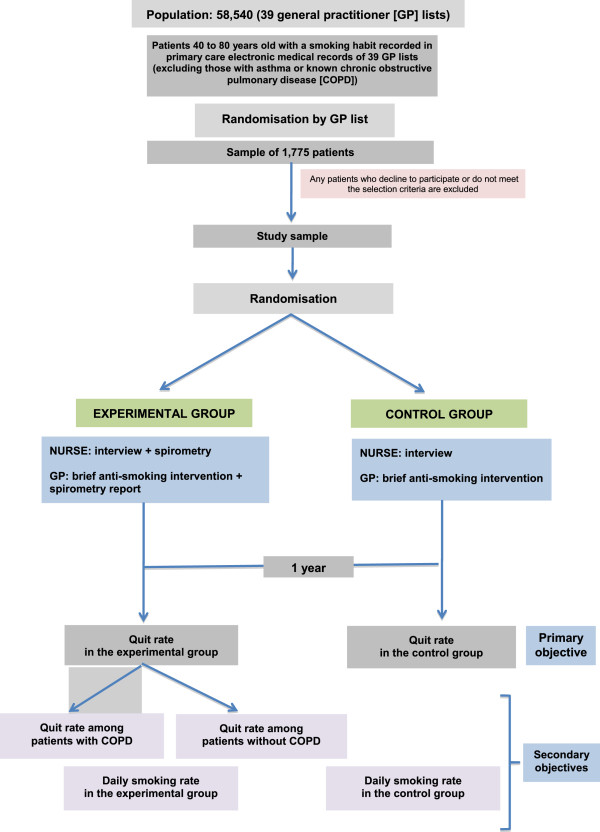
Study flow chart.